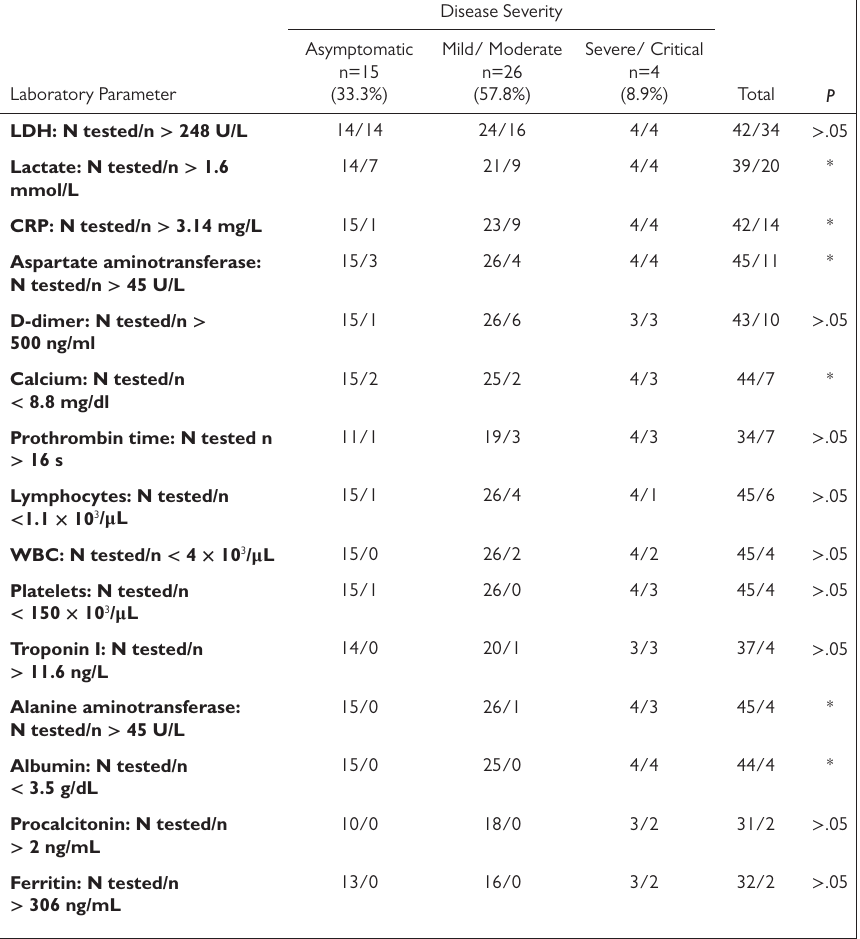
Table 3. Comparison of the Patients’ Laboratory Data According to Clinical Severity